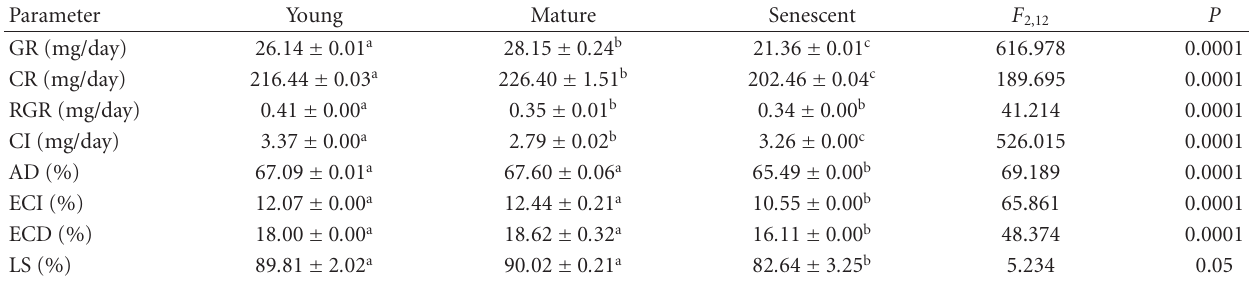
Table 6: Food utilization e ffi ciency measures of fifth instar larva of D. casignetum reared on young, mature, and senescent sunflower leaves. Parameter